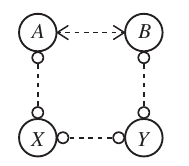
FIG. 13. Remaining class of DAGs after step 3.